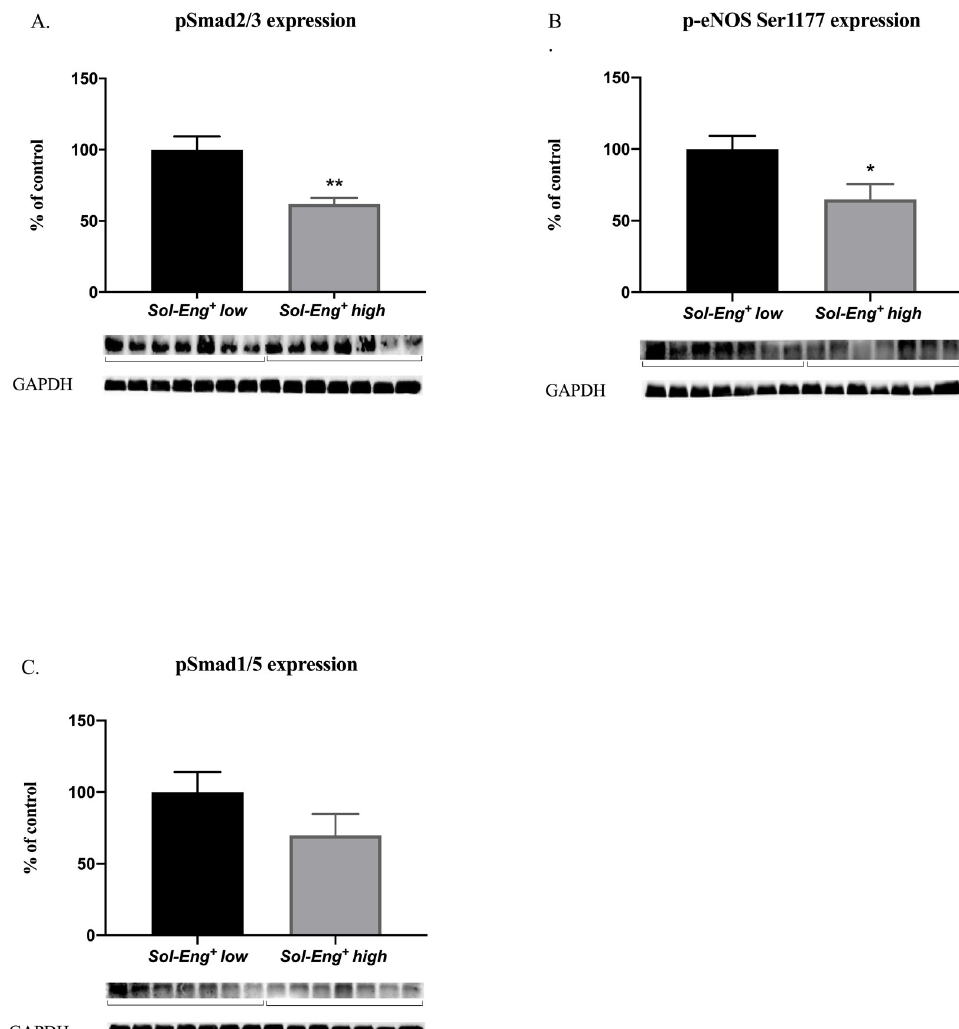
Fig 6. Western blot analysis of Smad expression and signaling in the heart. Expression of pSmad2/3 (A), p-eNOS Ser1177 (B) and pSmad1/5 (C) in total protein extracts from mice hearts. Top: densitometric analysis (control = 100%). Densitometric quantification of immunoreactive bands was recalculated to GAPDH signal. Bottom: representative immunoblots. Data are shown as mean ± S.E.M., Mann-Whitney test, � p � 0.05, �� p � 0.01. n = 7 mice per